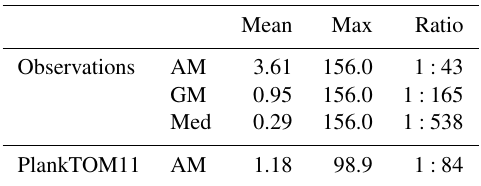
Table 7. Jellyfish biomass globally from observations (MAREDAT) and PlankTOM11. Three types of mean are given for the observa- tions; Med is the median, AM is the arithmetic mean and GM is the geometric mean. The ratios are all scaled to mean = 1. All units are in µgC L − 1